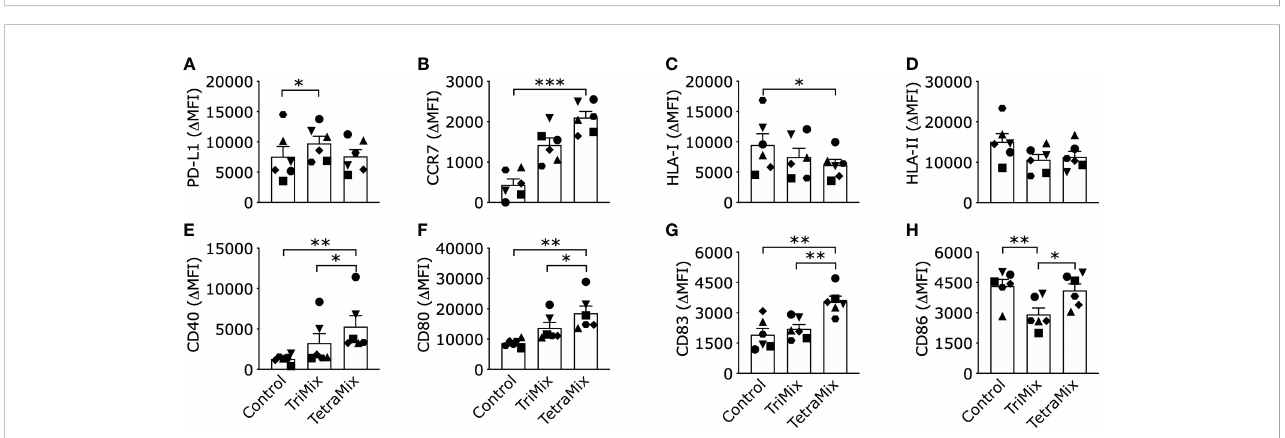
FIGURE 4 Phenotype of dendritic cells reprogrammed with TriMix or TetraMix mRNA. The bar graphs show the expression of PD-L1 (A) , CCR7 (B) , HLA-I (C) , HLA-II (D) , CD40 (E) , CD80 (F) , CD83 (G) and CD86 (H) , for three conditions, namely, tNGFR electroporated moDCs (Control), moDCs electroporated with TriMix or TetraMix mRNA. Results are expressed as the mean value of the delta-MFI ± standard error of the mean for six independent experiments (n=6). The delta-MFI is calculated from the MFI of the cells expressing the marker of interest subtracted by the MFI of the cells stained with the isotype control. Each symbol represents the data of an individual donor. Statistical signi fi cance is indicated as follows: *p < 0.05, **p < 0.01, ***p < 0.001, by Friedman ’ s